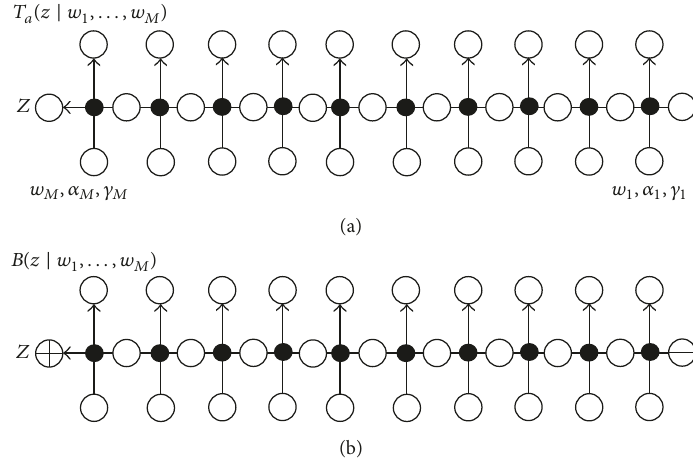
Figure 2: The monodromy matrix 𝑇 𝑎 (𝑧 | 𝑤 1 ,...,𝑤 𝑀 ) (7) (a) and the 𝐵 -operator 𝐵(𝑧 | 𝑤 1 ,...,𝑤 𝑀 ) (b).